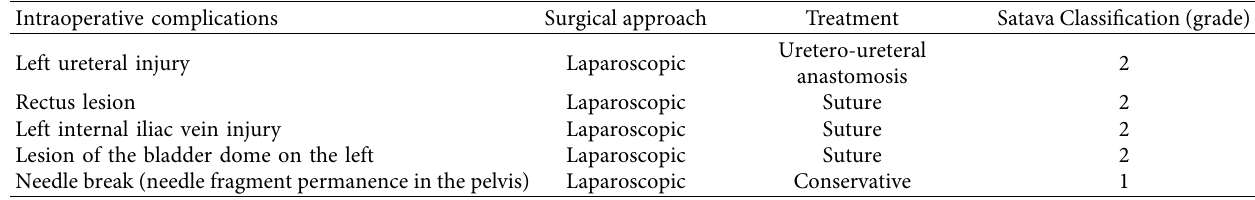
Table 3: Intraoperative complications, according to surgical approach, treatment, and Satava severity complication classification ( n � 5).